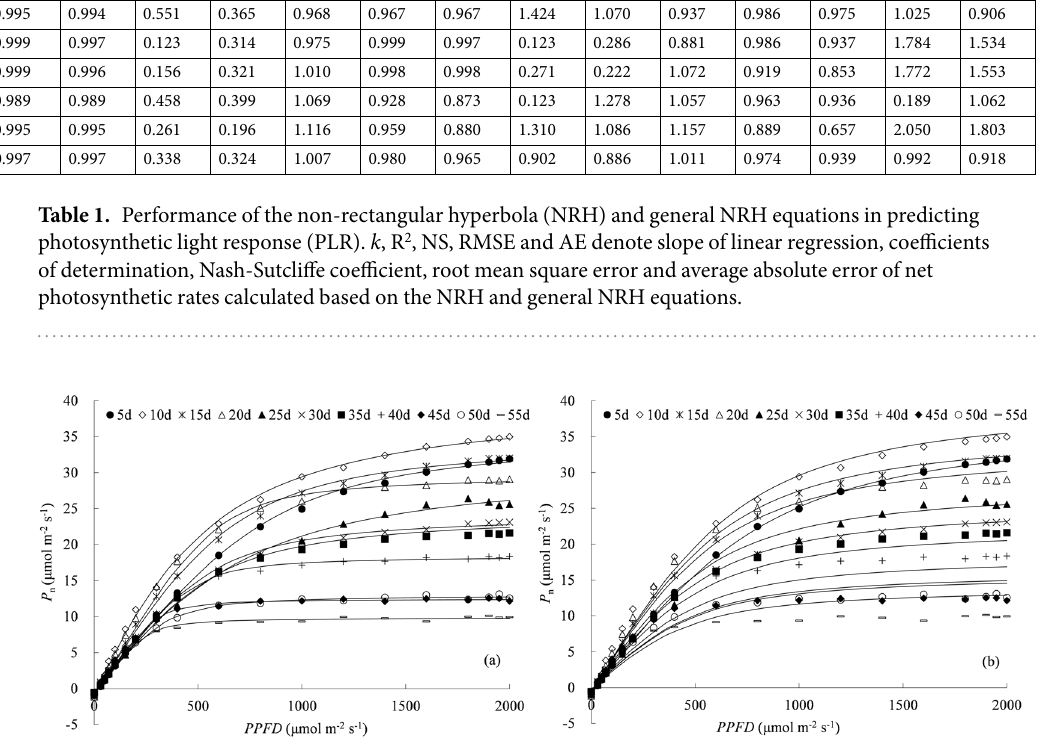
Figure 6. Net photosynthetic rates ( P n ) calculated by ( a ) the non-rectangular hyperbola (NRH) and ( b ) the general NRH equation for validation data. Lines represent the modelled P n , symbols are the observed P n (“ n d” in legend is the nominal leaf age for each leaf age group with ± 2 days span).